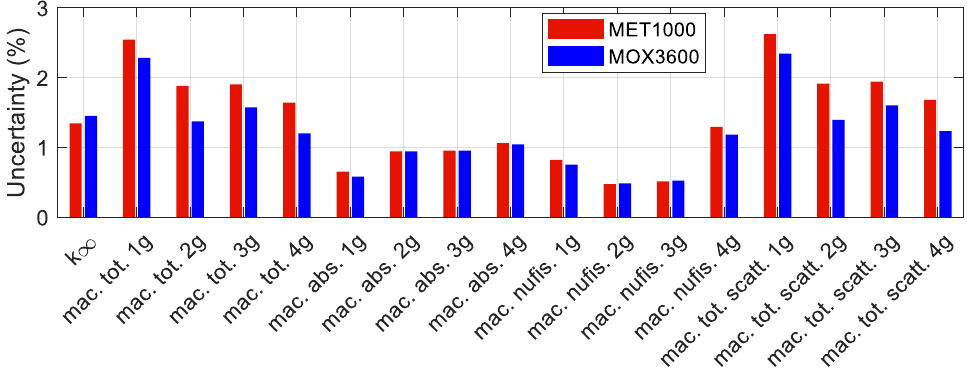
Figure 7. Uncertainty summary of fuel assembly